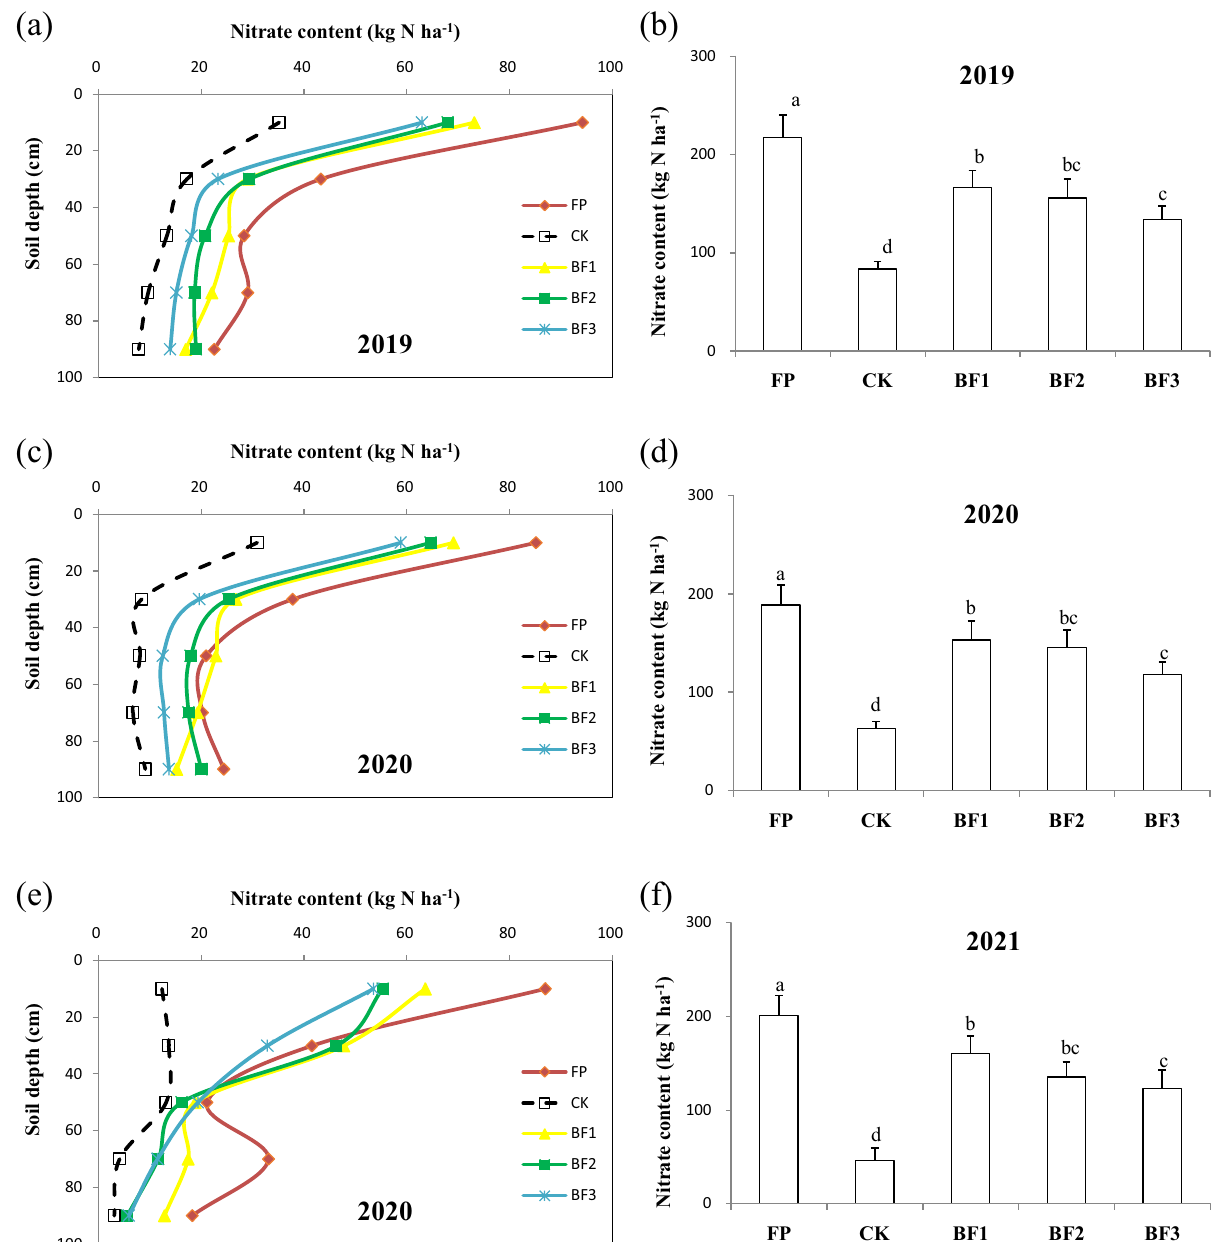
Figure 5. Changes in ( a , c , e ) different layers and ( b , d , f ) total NO 3− N content of 0–100 cm soil at spring wheat harvest for different fertilization treatments from 2019 to 2021. The data are the means and standard errors of three independent measurements. Values with different letters are significant at the P = 0.05 level.